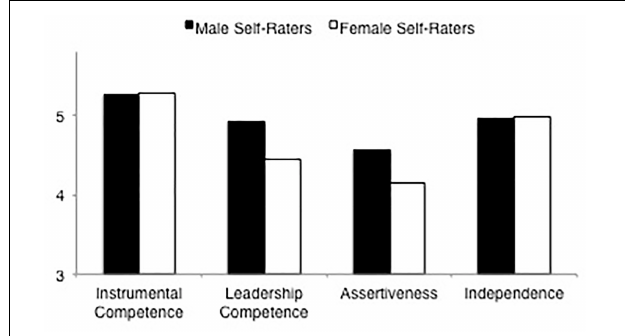
FIGURE 2 | Ratings of agency dimensions (instrumental competence, leadership competence, assertiveness, independence) by male and female self-raters.